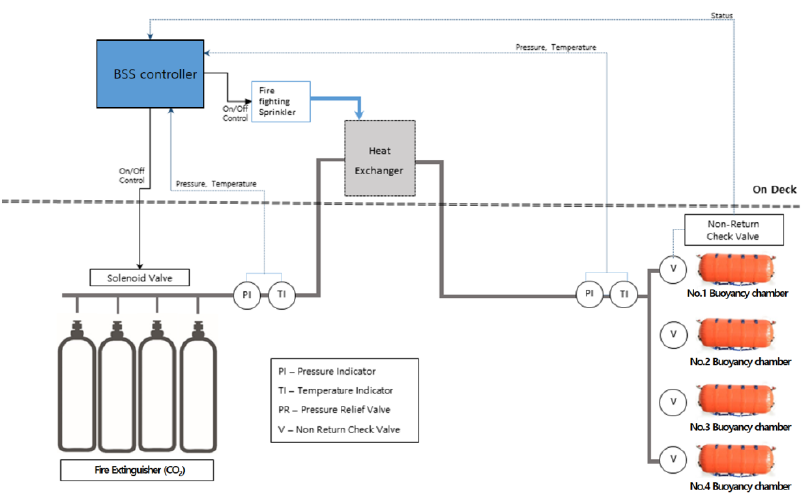
Figure 12. P and I diagram of the BSS.